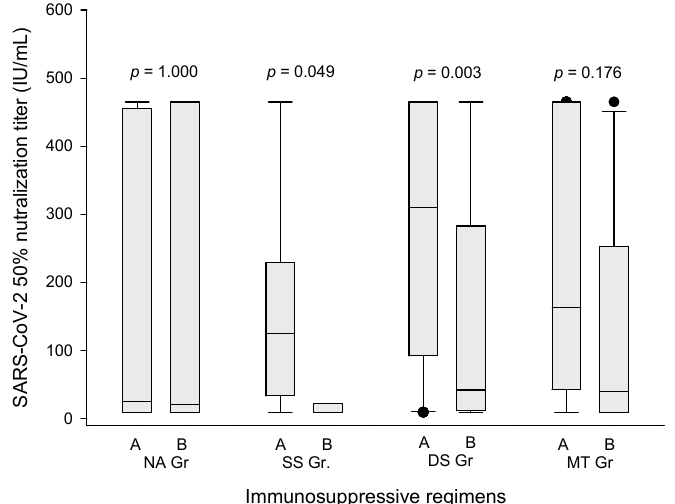
Figure 2. The COVID-19 NT 50 level according to trough concentration of tacrolimus. The median (interquartile) COVID-19 NT 50 was 42.25 (12.01–283.02) U/L in DS group patients with tacrolimus trough level ≥ 6.8 ng/mL (A), compared to 309.74 (92.76–465.04) U/L in the patients with tacrolimus trough level < 6.8 ng/mL (B) ( p = 0.003). The median (interquartile) COVID-19 NT 50 in SS group pa- tients was 22.63 (9.62–22.63) U/L in the patients with tacrolimus trough level ≥ 6.8 ng/mL (A), com- pared to 125.43 (33.74–229.37) U/L in the patients with tacrolimus trough level < 6.8 ng/mL (B) ( p = 0.049). For NA and MT group patients, tacrolimus levels did not show the influence on the produc- tion of COVID-19 NT 50 .